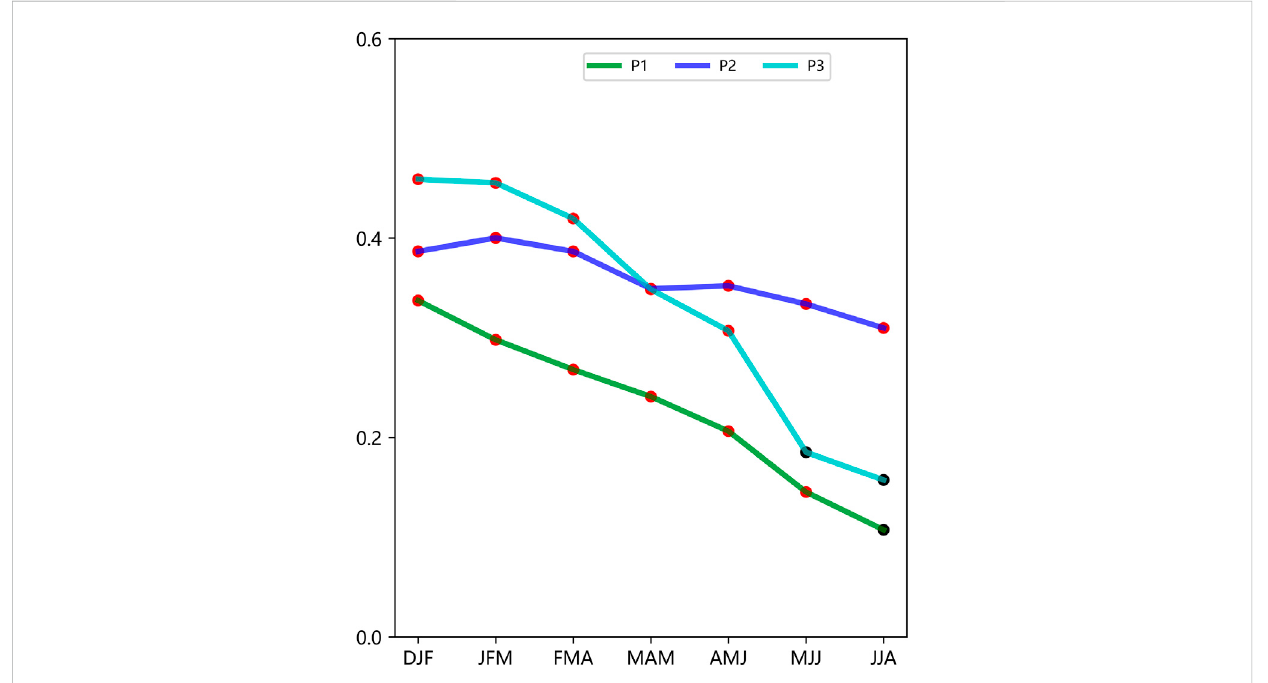
FIGURE 9 Regressioncoef fi cientofthepreviousautumnIODindexprojectedtotheregionalmeanSSTAintheTIO(10 ° S – 20 ° N,30 ° – 110 ° E)fromthepreviouswinterto the following summer. A red dot indicates a pass of the 90% signi fi cance test, and a black dot indicates a